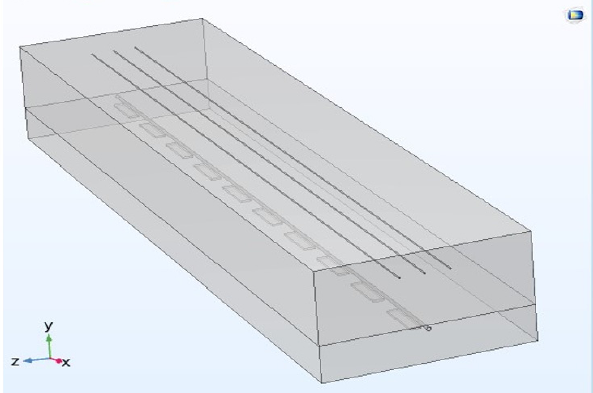
Figure 3. Geometric model diagram.